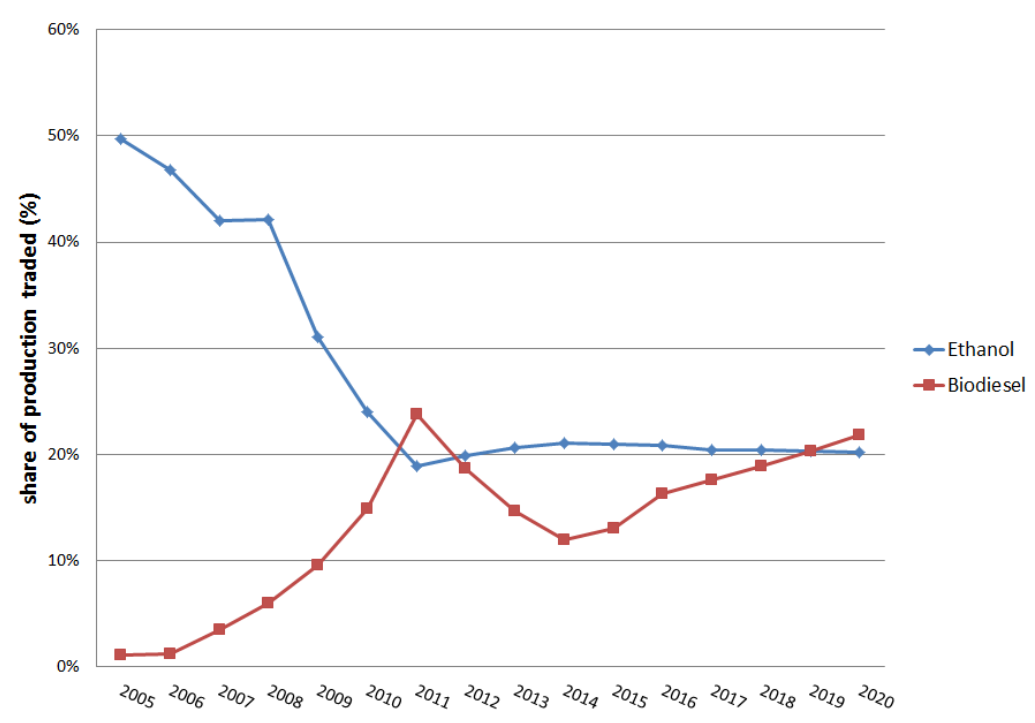
Figure 5. Traded shares of global ethanol and biodiesel production.